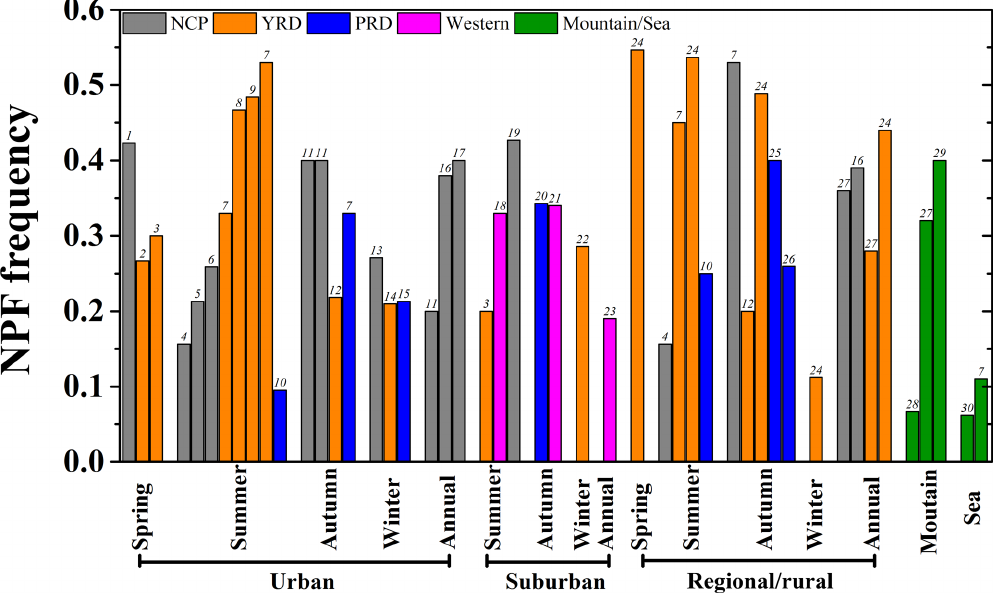
Figure 2. NPF frequency observed at different places in different seasons in China. The number on top of each column indicates the references of the data: 1 is Cai et al. (2017), 2 is Leng et al. (2014), 3 is Zhu et al. (2013), 4 is Yue et al. (2009), 5 is Zhang et al. (2011), 6 is Wang et al (2011), 7 is Peng et al. (2014), 8 is Yu et al. (2016), 9 is L. J. Shen et al. (2016a), 10 is Yue et al. (2013), 11 is Shen et al. (2016b), 12 is Dai et al. (2017), 13 is Jayaratne et al. (2017), 14 is Xiao et al. (2015), 15 is Tan et al. (2016), 16 is Wang et al. (2013b), 17 is Wu et al. (2007), 18 is Gao et al. (2011), 19 is Gao et al. (2012), 20 is Guo et al. (2012), 21 is X. H. Zhang et al. (2017), 22 is Herrmann et al. (2014), 23 is Peng et al. (2017), 24 is Qi et al. (2015), 25 is Wang et al. (2013d), 26 is Liu et al. (2008), 27 is X. J. Shen et al. (2016b), 28 is X. R. Zhang et al. (2017), 29 is Lv et al. (2018), and 30 is Liu et al.